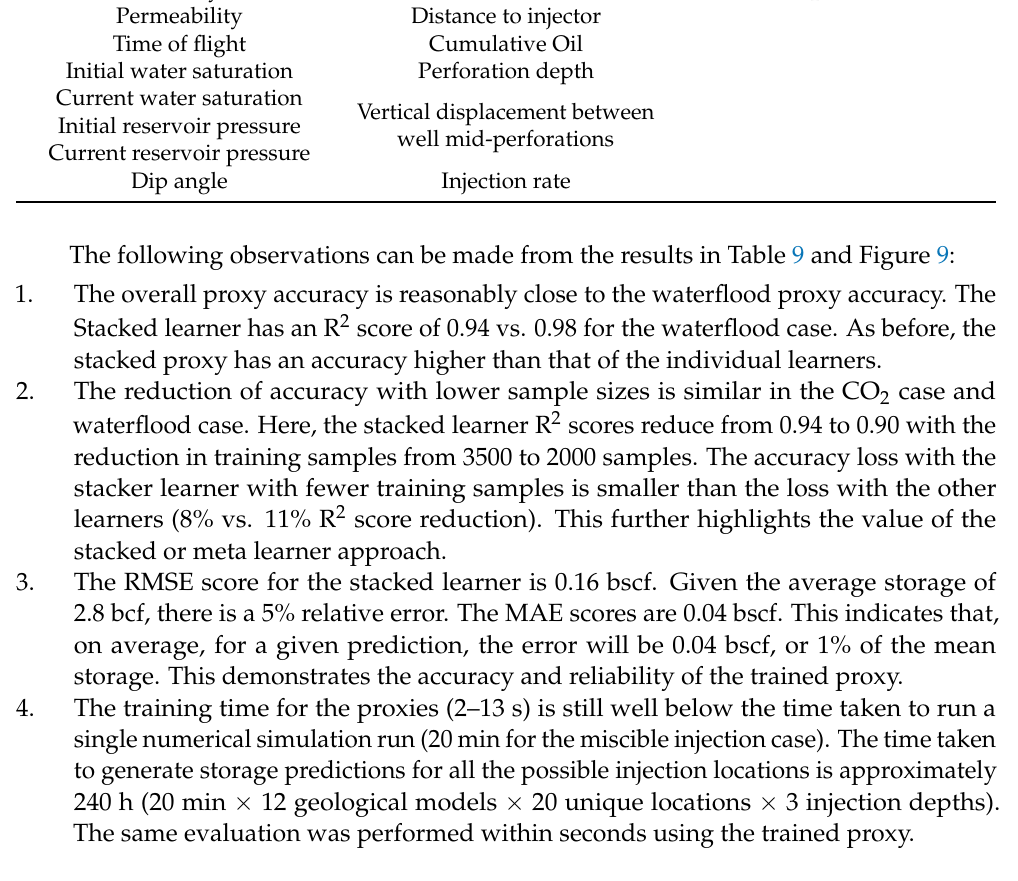
Table 9. Proxy results for 3500 samples for CO 2